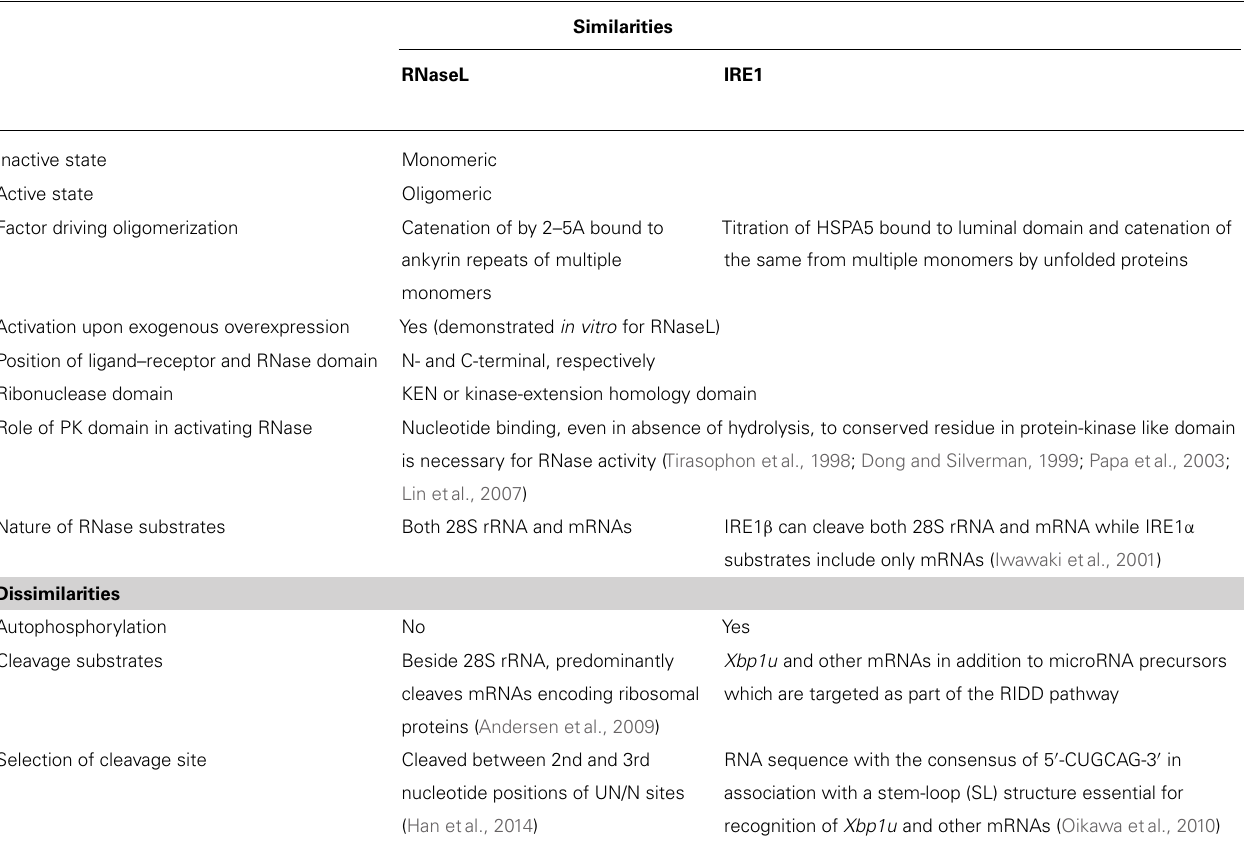
Table 1 |A comparison of the structural and biochemical properties of RNaseL and IRE1, showing similarities and